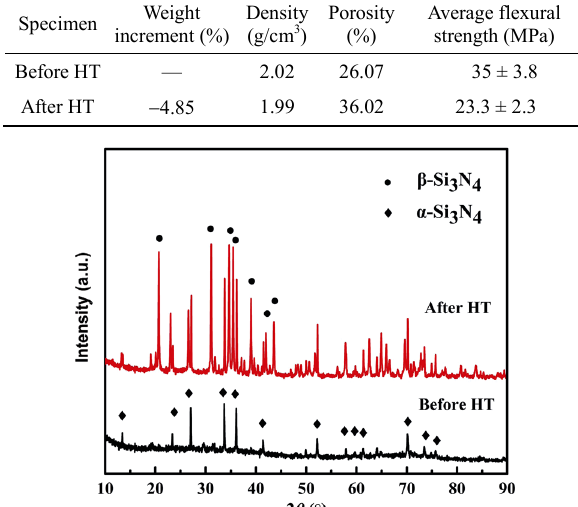
Fig. 8 XRD patterns of porous Si 3 N 4 –Si 3 N 4 composite ceramics (S4) before and after heat treatment. “HT” represents “heat treatment”.